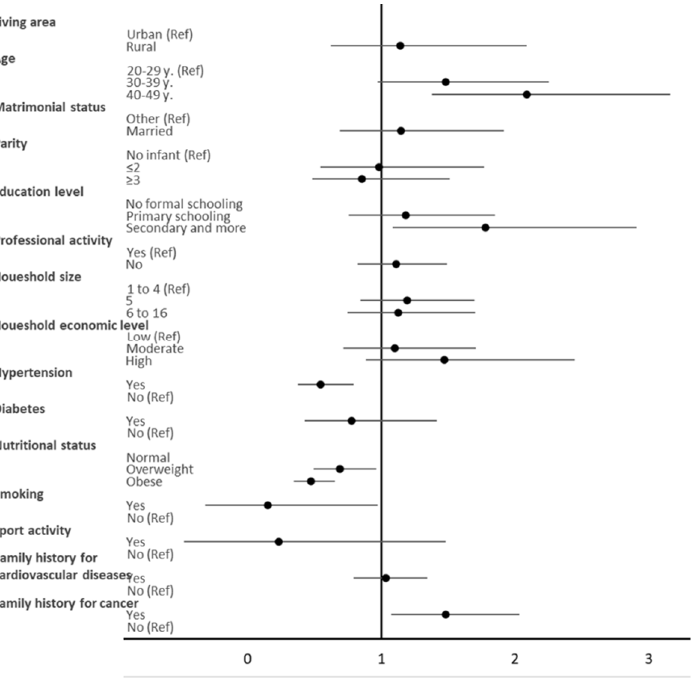
Figure 1. Adjusted odds ratio (OR; 95% CI) of high HDL-C for age (education level, marital status, professional activity, household economic level, household size, and living area), lifestyle (self- reported practice of regular physical activity and smoking), and biological factors (hypertension status, diabetes status, family history of cancer, and family history of cardiovascular